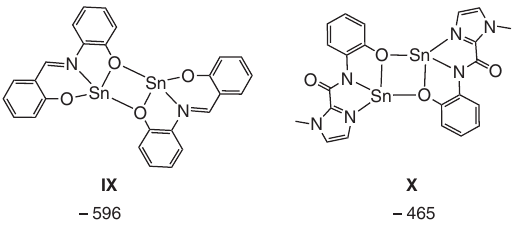
Scheme 3 Examples of tetracoordinate Sn(II) complexes and their 119 Sn NMR shifts.